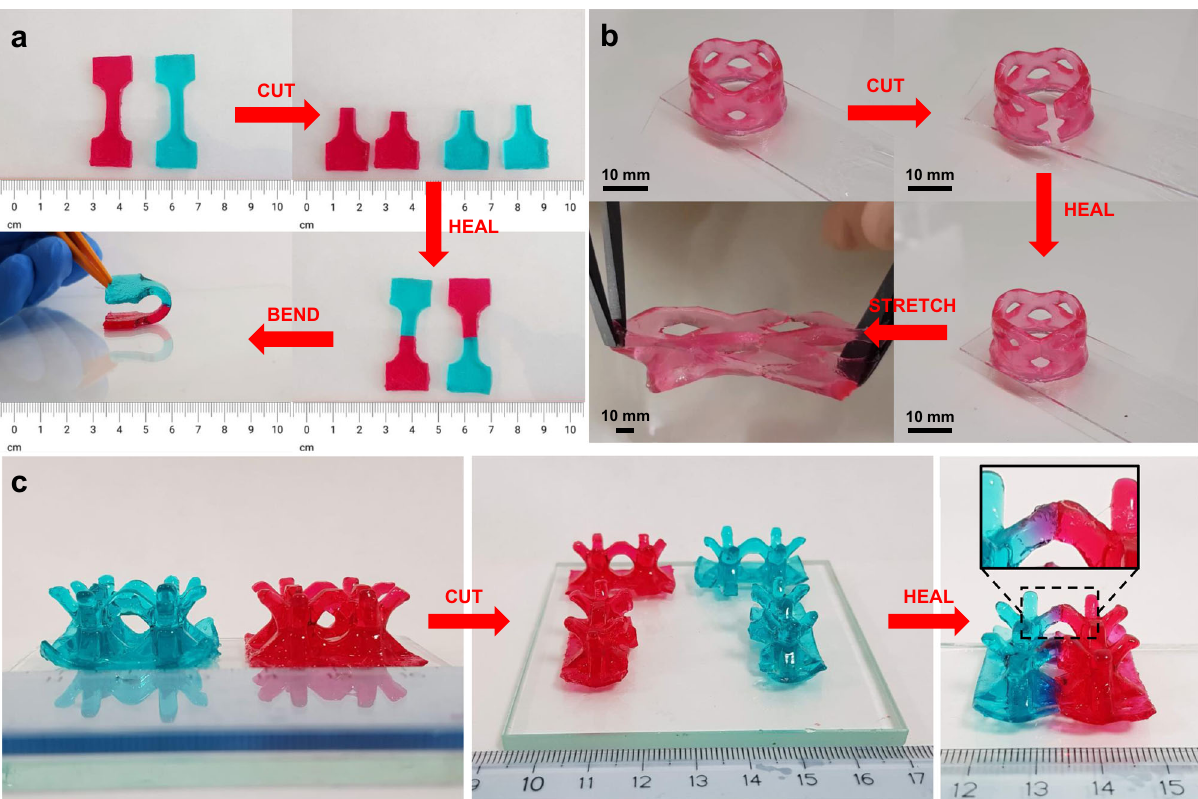
Fig. 3 Restoration of cut and rejoined objects printed with a ratio of AAc/PVA of 0.8. a Tensile test specimens printed with methyl red sodium salt dye and brilliant green dye. The samples could withstand a bending deformation immediately upon rejoining. b Holed cylindrical structure printed with methyl red sodium salt dye. The reconnected sample could endure a stretching deformation after healing for 2 h. c Body-centered cubic lattice-like structures printed with methyl red sodium salt dye and brilliant green dye for better visual comprehension. Diffusion at the interface after 12 h of contact is clearly visible (inset) because of the gradient of the